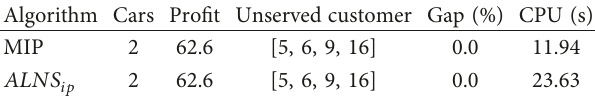
Table 5: Computational results of the example. Algorithm Cars Profit Unserved customer Gap (%) CPU